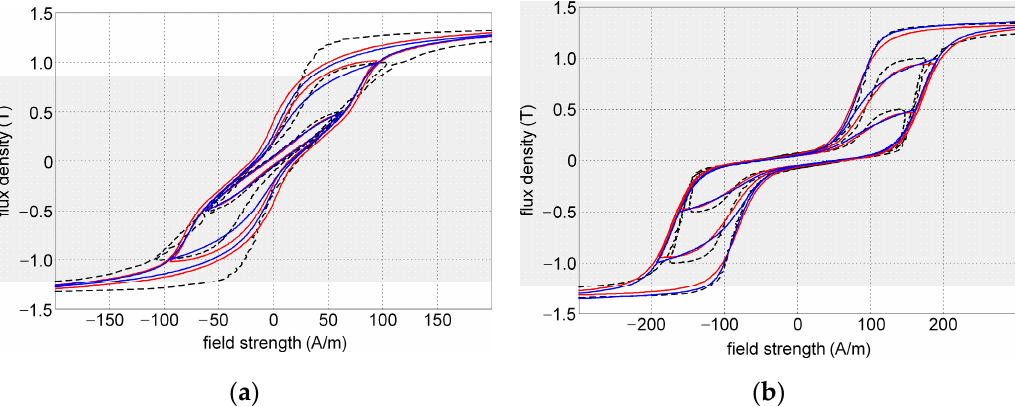
Figure 10. Symmetrical hysteresis loops for some assumed values of the field strength: ( a ) the dynamo sheet M530-50A; ( b ) the transformer sheet M120-27S for the rolling direction; black line—measured loops, red and blue lines—calculated loops using the basic or inverse approximation of the hysteresis loop.